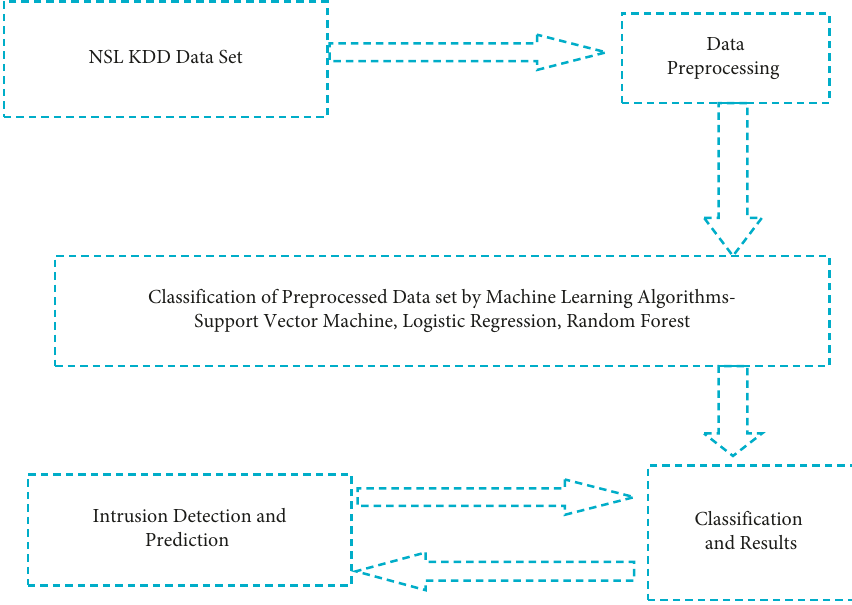
Figure 2: A framework for IDS for IoT networks for agriculture